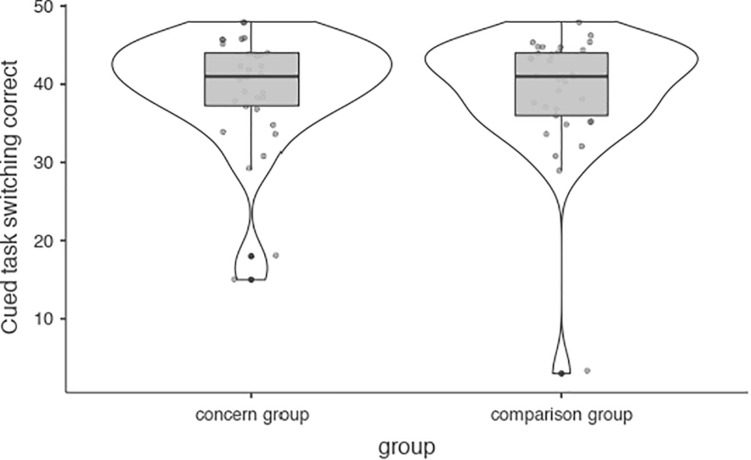
WHO5 general wellbeing.